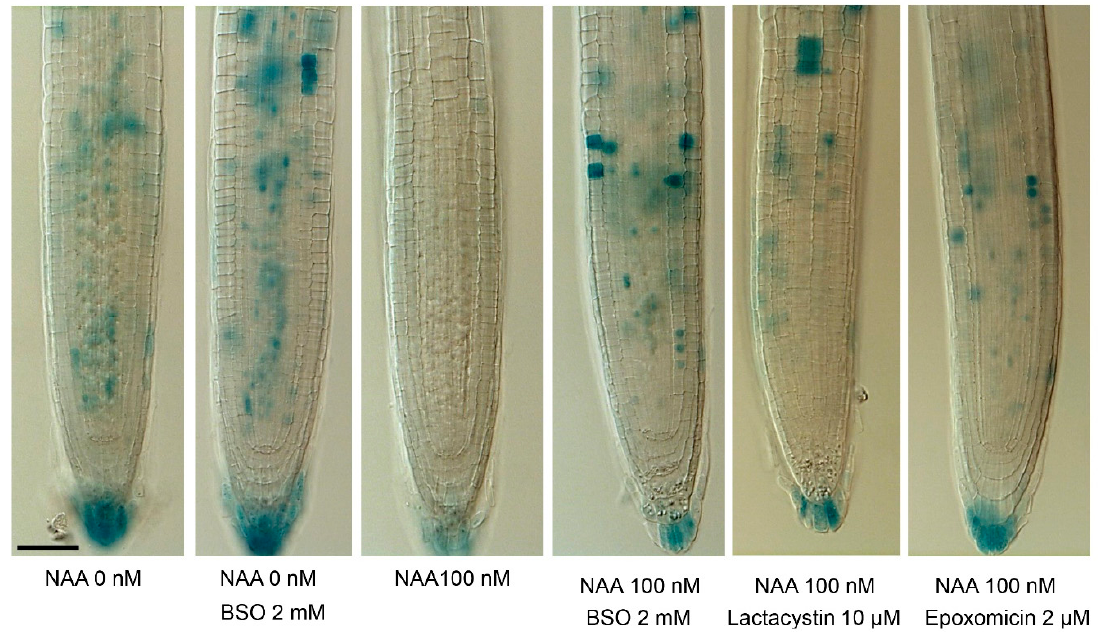
Figure 4. E ff ect of BSO, NAA, and proteasome inhibitors on the stability of AXR3NT-GUS. Four-day-old HS::AXR3NT-GUS seedlings were adapted in liquid medium and then treated for 12 h with BSO and 20 min with proteasome inhibitors. The seedlings were then treated for 1.5 h with 100 nM NAA and subjected to heat-shock at 37 °C for 1.5 h. GUS assays were performed for next 1.5 h. Scale bar − 50 µm.